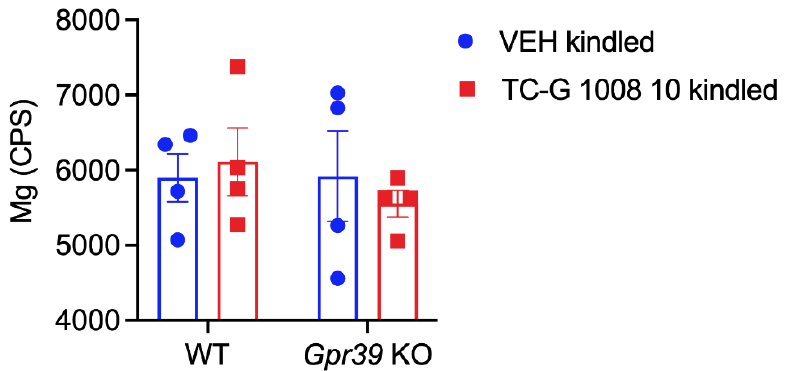
Figure 6. The effects of the PTZ kindling model and chronic treatment with TC-G 1008 (10 mg/kg i.p.) in Gpr39 -KO or WT (C57BL/6/Tar × CBA/Tar) mice on total magnesium in the hippocampus. Laser ablation inductively coupled plasma mass spectrometry (LA-ICP-MS) analysis was per-